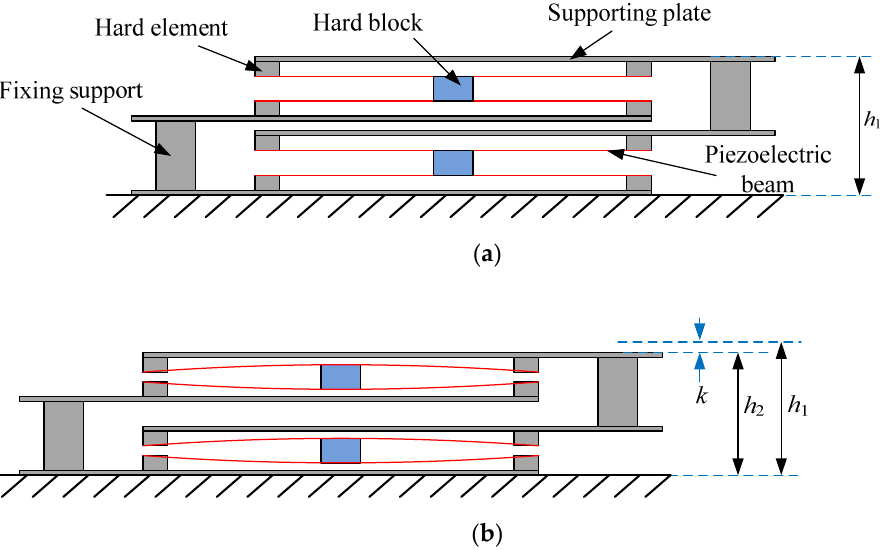
Figure 2. Design and working principle of the multi-layer interdigitated piezoelectric beam structure: ( a ) before stepped; ( b ) after stepped.